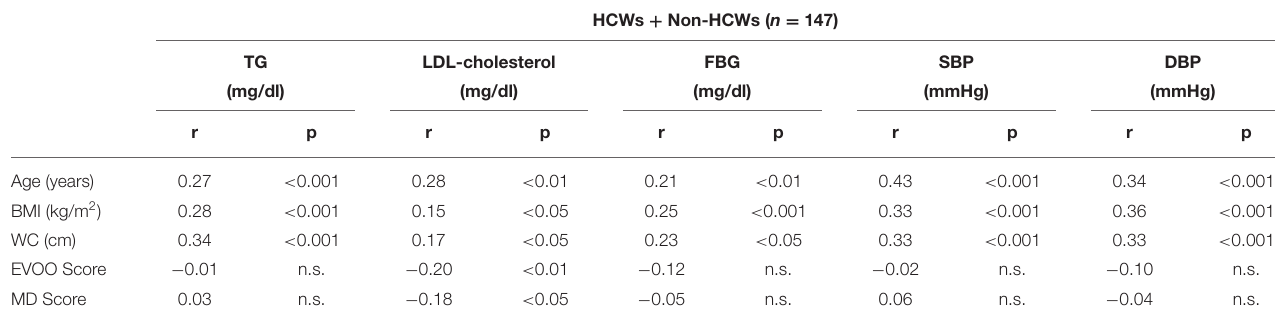
TABLE 3 | Correlation matrix for continuous variables across the entire study